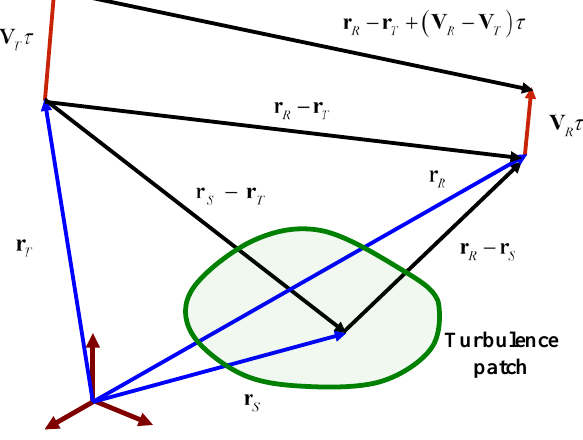
Fig. 2. Scattering geometry at times t 1 and t 2